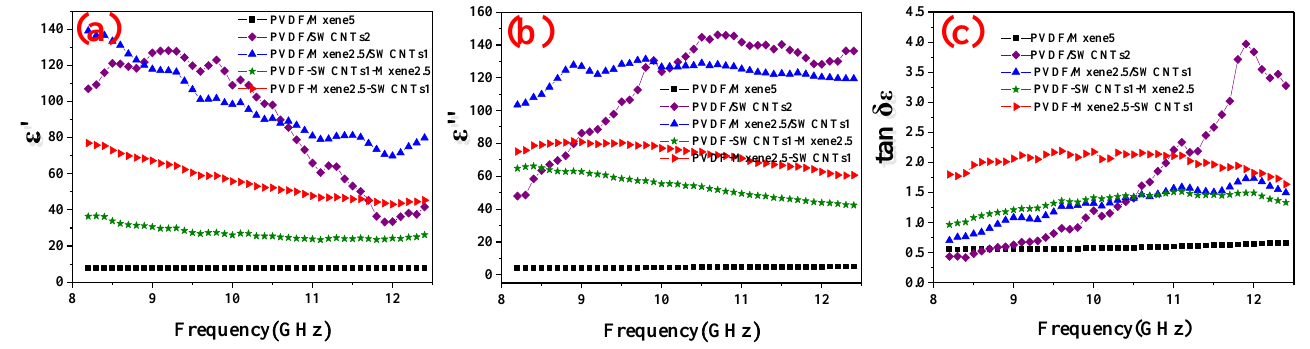
Figure 7. ( a ) ε ′, ( b ) ε″ , ( c ) dielectric loss (tan δ ε = ε ″ /ε ′ ) of PVDF/MXene5, PVDF/SWCNTs2, Figure 7. ( a ) ε (cid:48) , ( b ) ε ” , ( c ) dielectric loss (tan δ ε = ε ”/ ε (cid:48) ) of PVDF/MXene5, PVDF/SWCNTs2, PVDF/MXene2.5/SWCNTs1, PVDF-SWCNTs1-MXene2.5, and PVDF-MXene2.5-SWCNTs1. PVDF/MXene2.5/SWCNTs1, PVDF-SWCNTs1-MXene2.5, and PVDF-MXene2.5-SWCNTs1.